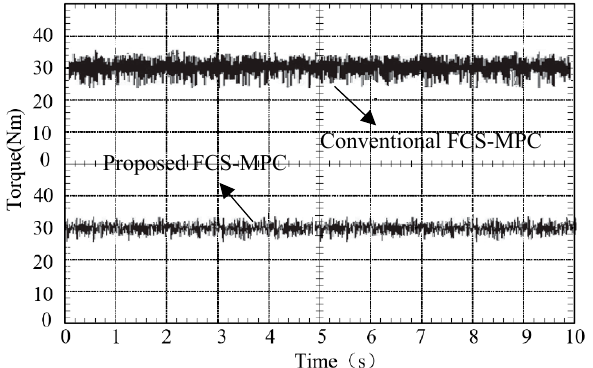
Figure 13. Torque steady-state responses (IPMSM).